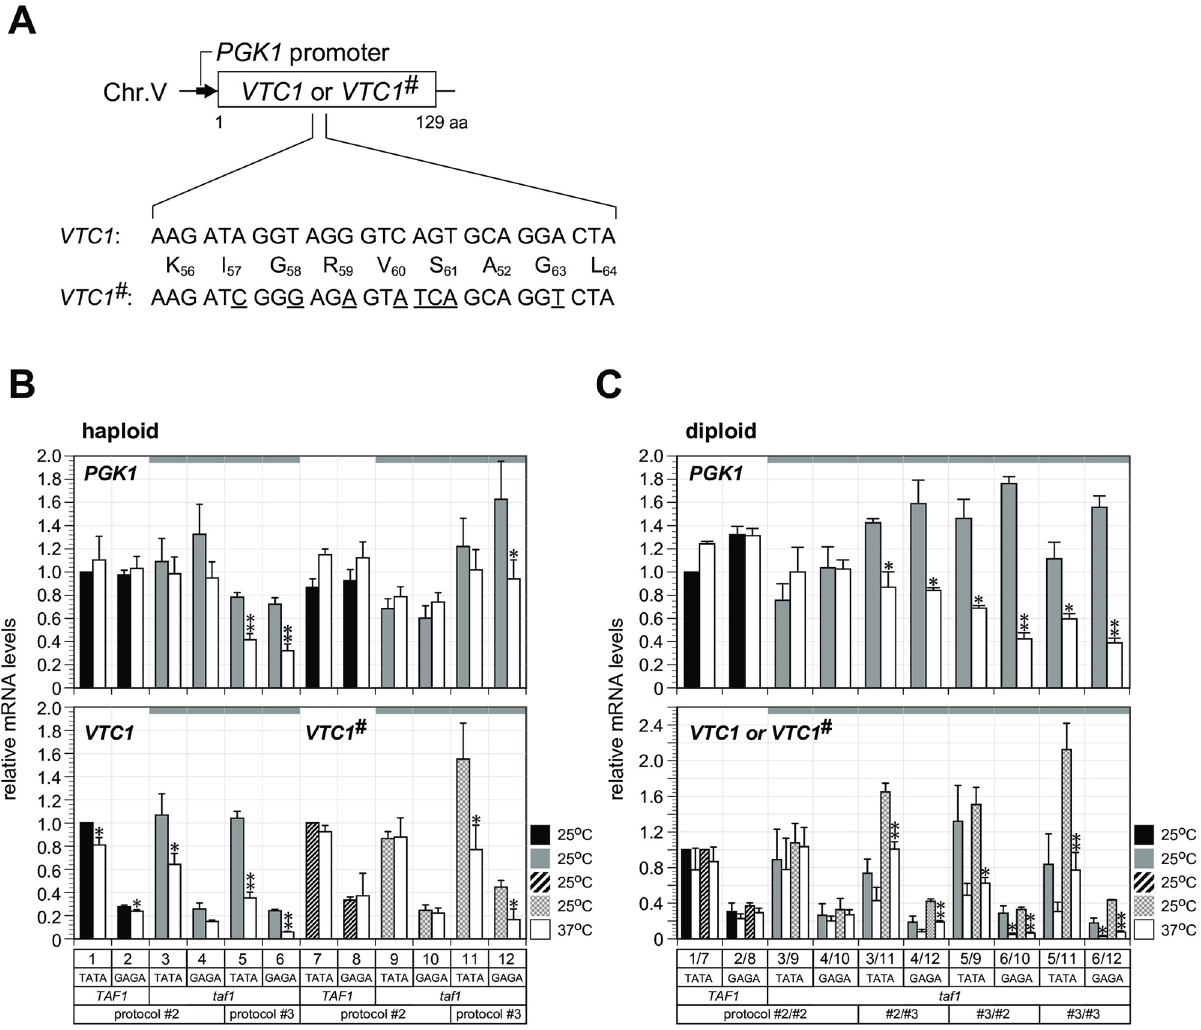
Fig 2. Examination of Taf1/TFIID dependence of PGK1 transcription using the allele-specific VTC1 reporter system. (A) Strains used in experiments to examine allele-specific expression of the PGK1 promoter were constructed by replacing the VTC1 reporter with the VTC1 # reporter carrying eight silent mutations (underlined). Promoter activities were analyzed by RT-qPCR using primers specific for each VTC1 reporter allele. (B) RT-qPCR analysis to measure mRNA levels of PGK1 (top panel) or VTC1/VTC1 # (bottom panel) in the twelve haploid strains carrying VTC1 (lanes 1–6) or the VTC1 # reporter (lanes 7–12) driven by the PGK1 promoter in which the TATA box was intact (odd-numbered lanes) or substituted with the GAGA sequence (even-numbered lanes), as indicated below the bottom panel. These strains were generated by construction protocol #2 (lanes 1–4 and 7–10) or #3 (lanes 5–6 and 11–12), as indicated below the bottom panel and described in S1A Fig. The strains used are YTK19317 (lane 1), YTK19319 (lane 2), YTK19401 (lane 3), YTK19402 (lane 4), YTK19489 (lane 5), YTK19492 (lane 6), YTK19663 (lane 7), YTK19665 (lane 8), YTK19664 (lane 9), YTK19666 (lane 10), YTK19716 (lane 11), and YTK19717 (lane 12). Cultivation and data presentation were conducted as described in Fig 1A. (C) RT- qPCR analysis to measure PGK1 mRNA levels (top panel) or VTC1/VTC1 # mRNA levels (bottom panel) in the ten diploid strains carrying both of the VTC1 and VTC1 # reporters driven by the PGK1 promoter in which the TATA box was intact (lanes 1/7, 3/9, 3/11, 5/9, and 5/11) or substituted with the GAGA sequence (lanes 2/8, 4/10, 4/12, 6/10, and 6/12), as indicated below the bottom panel. These diploid strains YTK19748 (lanes 1/7), YTK19749 (lanes 2/8), YTK19765 (lanes 3/9), YTK19766 (lanes 4/10), YTK19767 (lanes 3/11), YTK19768 (lanes 4/12), YTK19746 (lanes 5/9), YTK19747 (lanes 6/ 10), YTK19763 (lanes 5/11), and YTK19764 (lanes 6/12), were obtained by crossing the two specific haploid strains listed in each lane of B . For instance, YTK19748 (lanes 1/7) was obtained by crossing YTK19317 (lane 1 in B ) and YTK19663 (lane 7 in B ). The other lanes are also numbered accordingly. Cultivation and data presentation were conducted as described in Fig 1A, except that the two sets of data measured individually for each reporter allele were presented together in one